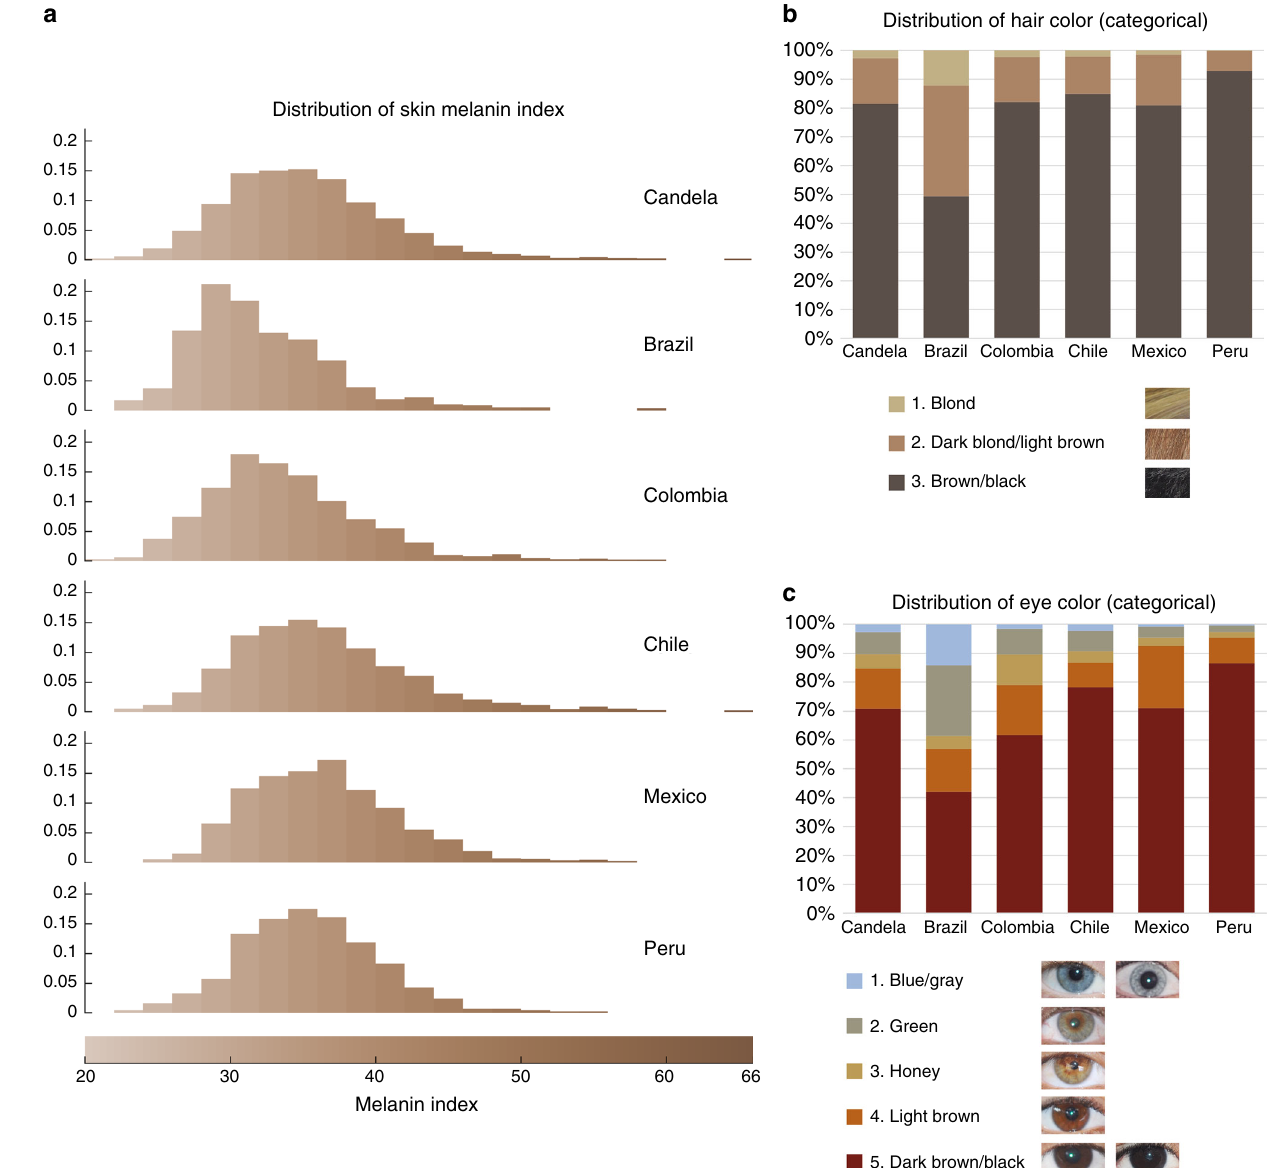
Fig. 1 Distribution of skin, hair and eye pigmentation in the CANDELA sample. a Frequency distribution of skin melanin index (MI). Histograms are shown for the full CANDELA sample and for each country sample separately. To facilitate relating MI values to skin color, the MI values ( x -axis) were converted to approximate RGB values (scale at the bottom, Supplementary Figure 16). b Stacked bar plots showing the frequency (percent) of the three hair color categories. Bar colors correspond approximately to the sample images for each category shown at the bottom (with the ordinal numbering used in the association analyses shown next to each category). c Stacked bar plots showing the frequency (percent) of eye color categories. Bar colors correspond approximately to the sample images of eyes as shown at the bottom (with the ordinal numbering used in the association analyses shown next to each category). Categories 1 and 5 are composite categories, respectively of blue/gray and dark brown/black and examples of each of the sub-type are